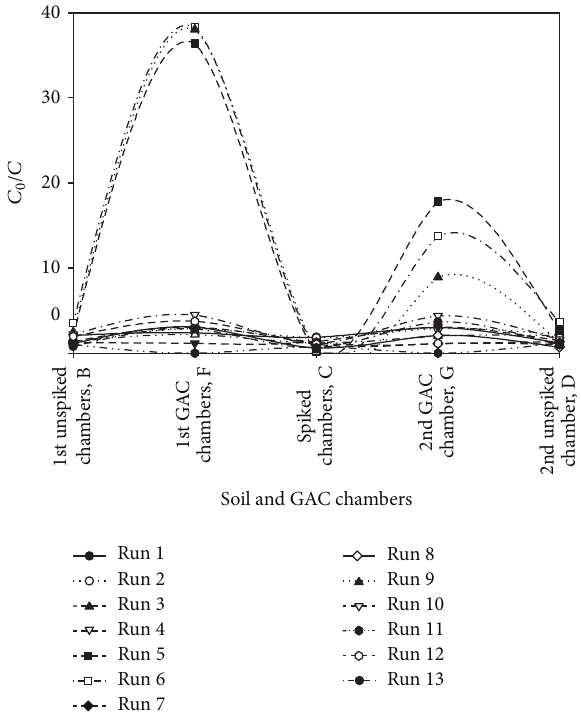
Figure11:TrivalentCrdistributionandmigrationfromthecontam- inated chamber to the GAC chambers after 13 tests.